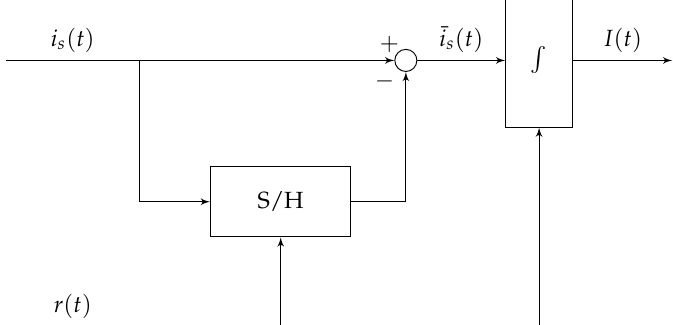
Figure 5. Circuitry used for the implementation of the IDIM technique, including an offset-eliminating stage and an analog integrator with reset capability.